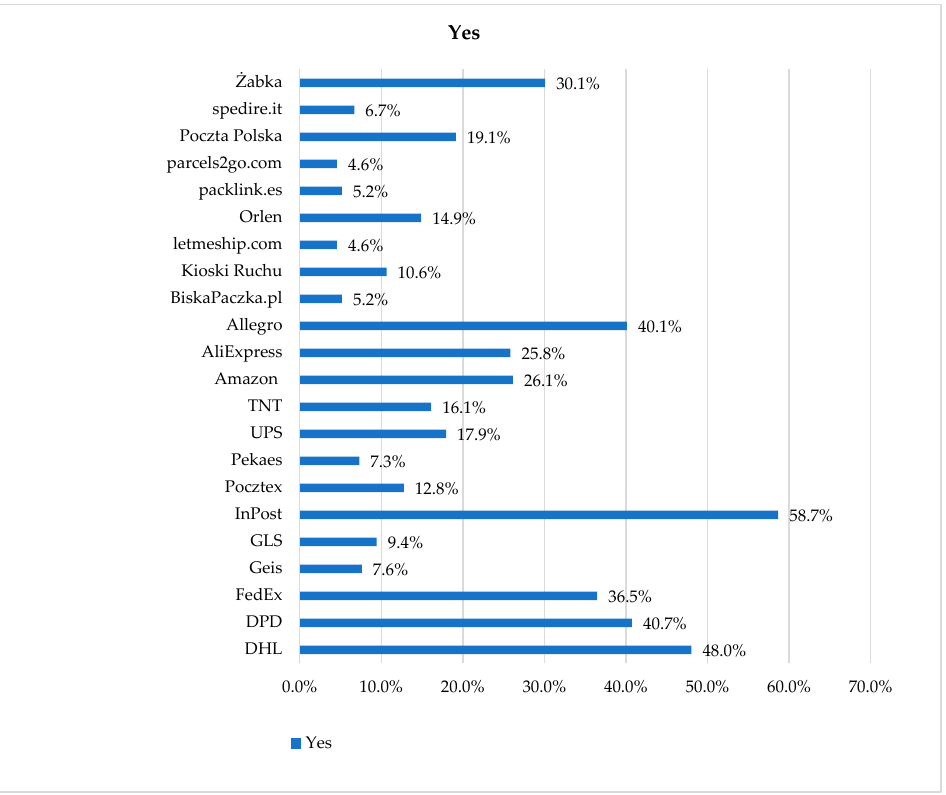
Figure 5. Compliance with the principles of sustainable development by companies offering services of logistics delivery.